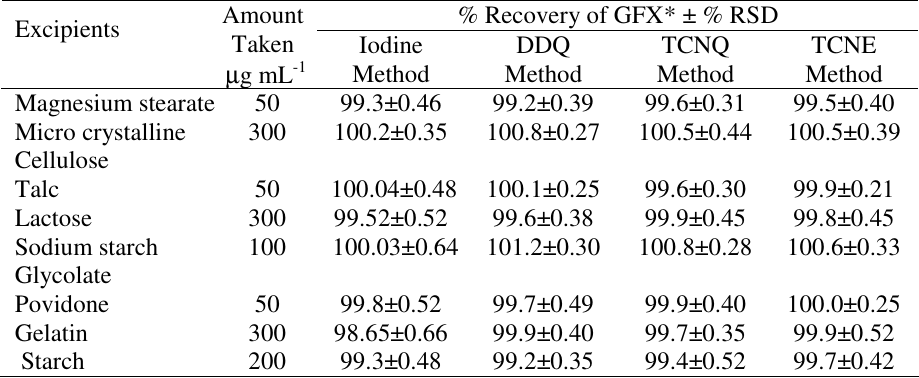
Table 1. Determination of GFX in the presence of excipients